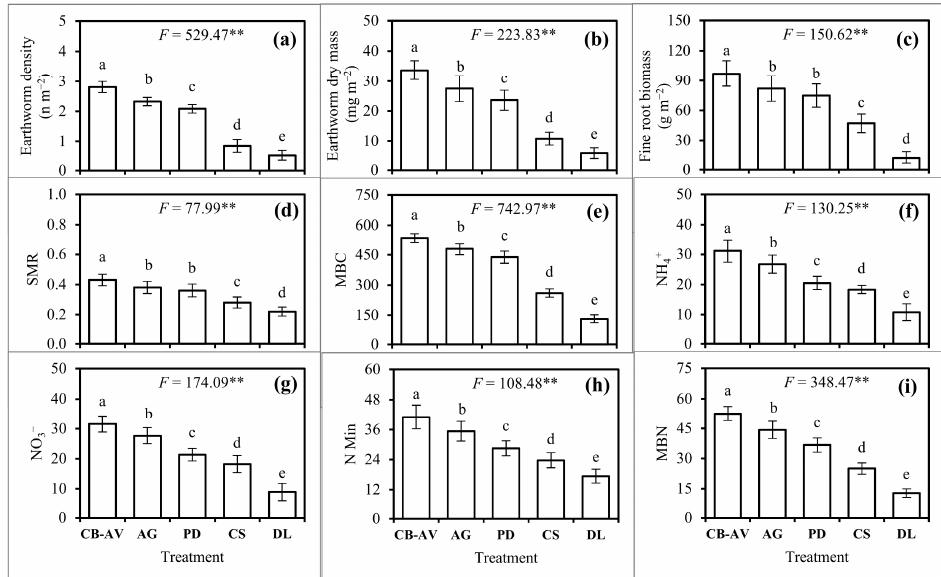
Figure 5. Mean values and standard deviation (SD) of soil biological and biochemical properties in the different treatments of tree species. Results of the ANOVAs ( F test and p value) are given. Different letters after means within each treatment indicate significant differences by Duncan’s test ( p <